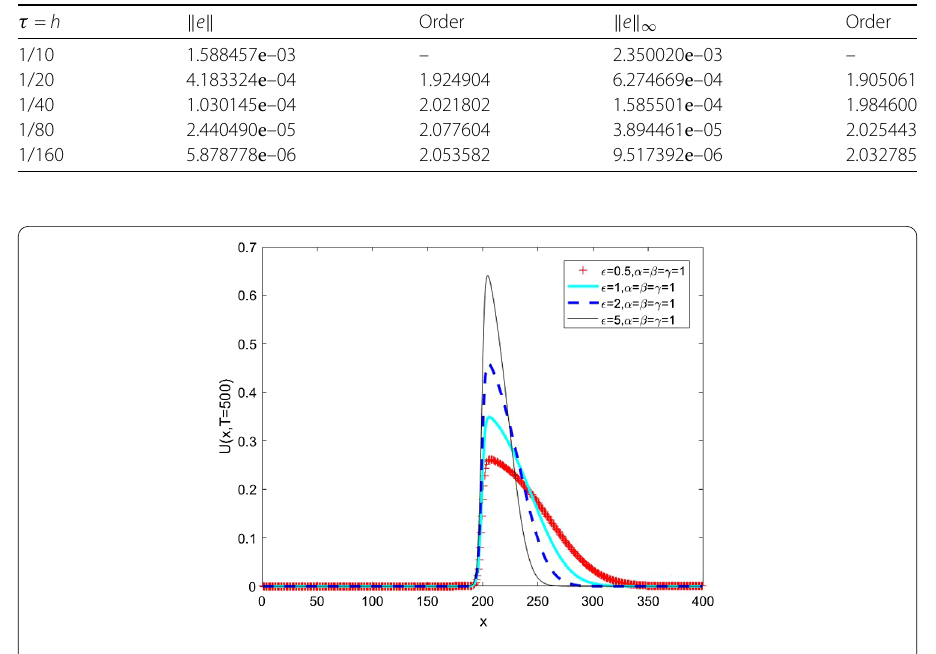
Figure 1 (cid:4) ranging from 0.5 to 5 with fixed α = β =